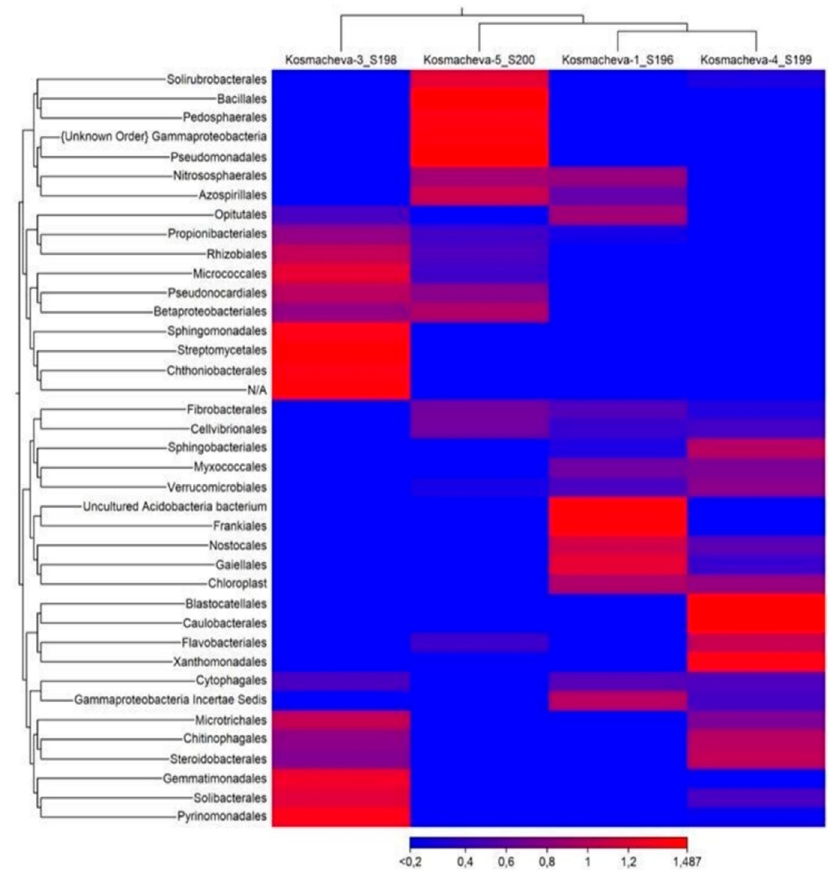
Figure 3. Thermal map of the bacteria abundance dynamics at the order level. The color bar indicates OTU relative abundances expressed as Z-scores.